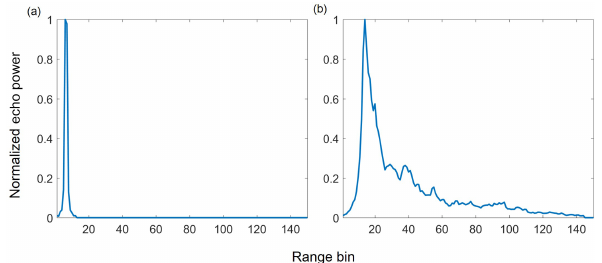
Figure 1. Representative waveforms of (a) leads and (b) sea ice over the Arctic Ocean selected by the N-FINDR algorithm from January to May and October to December between 2011 and 2016. Refer to the methods section for the N-FINDR